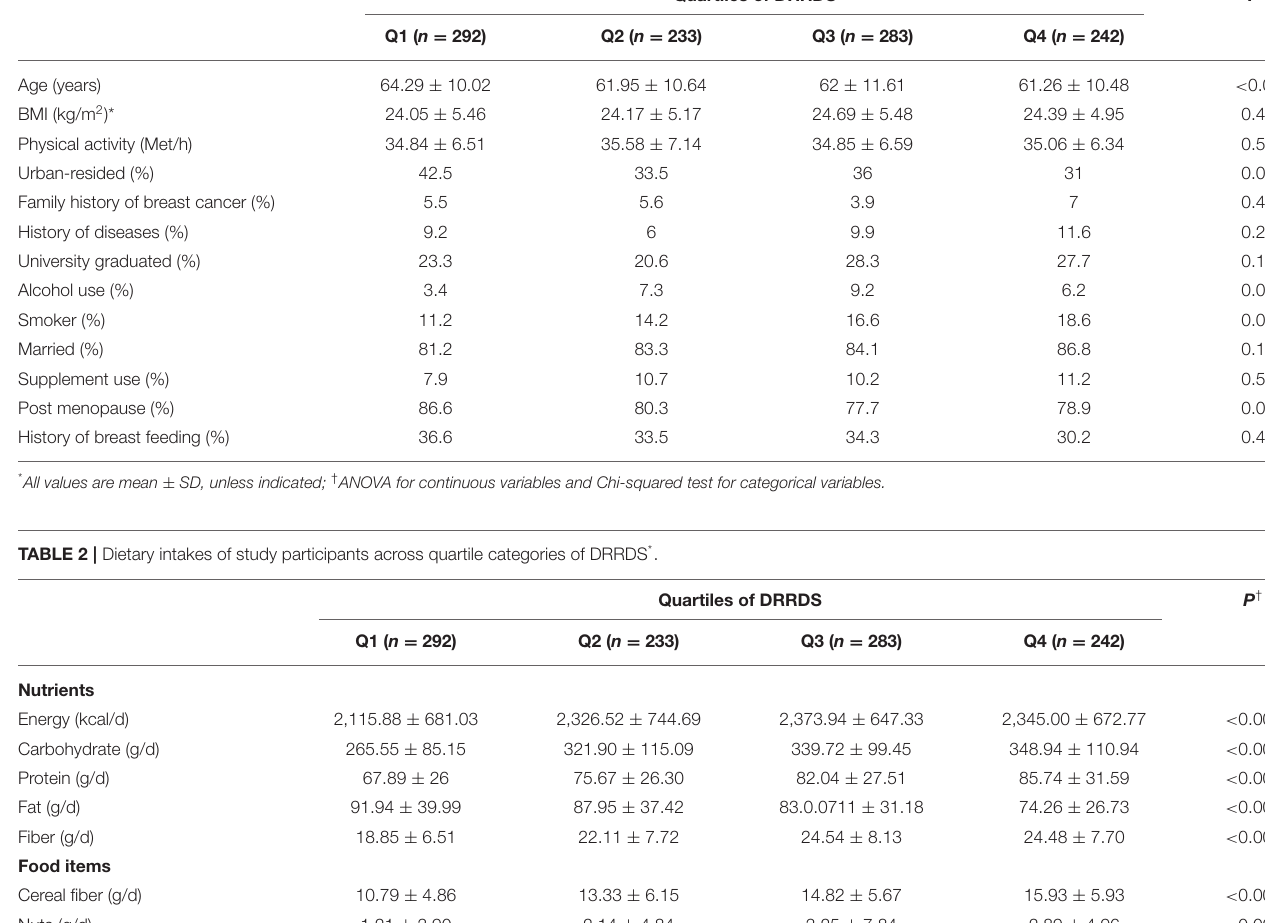
Quartiles of DRRDS